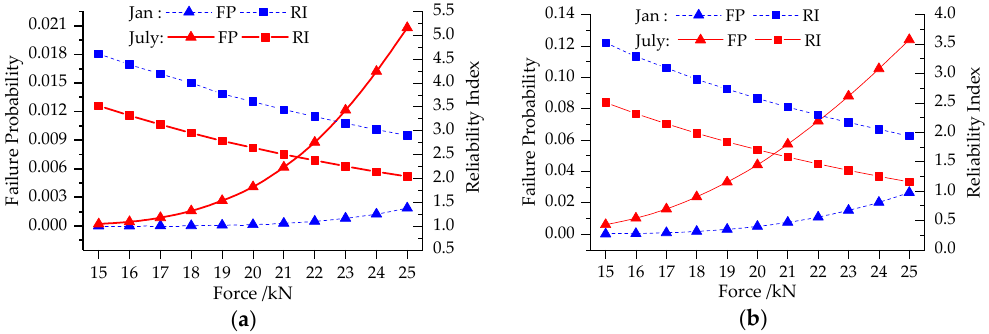
Figure 15. RI with external force variation: ( a ) Case 1; ( b ) Case 3.